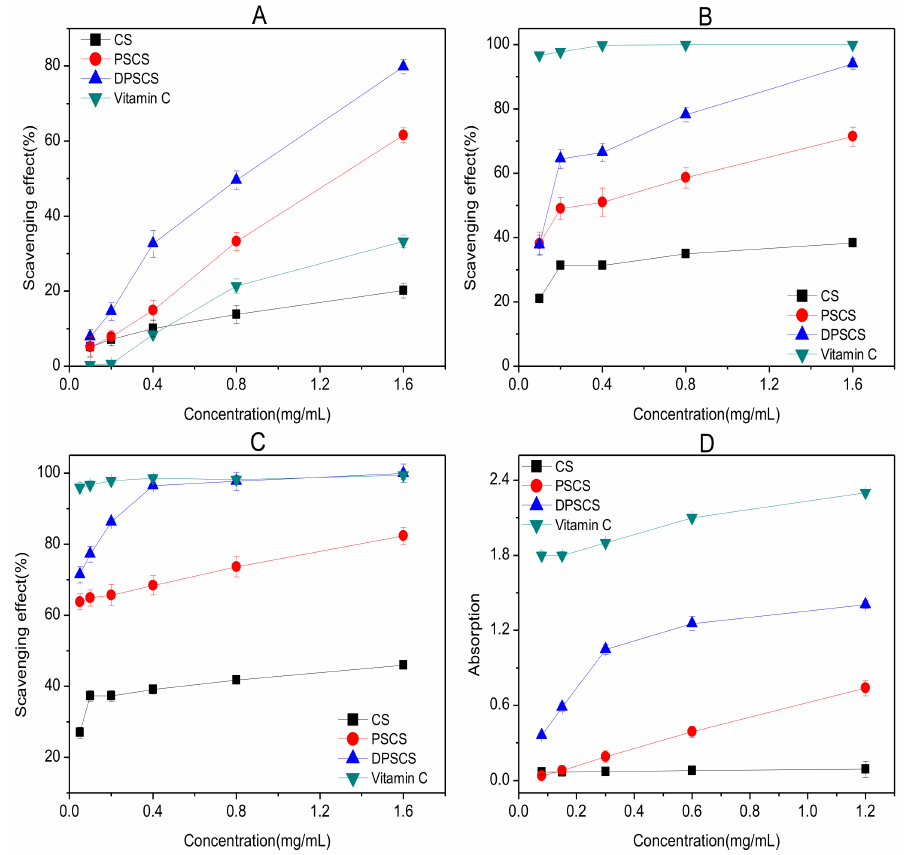
Figure 4. Antioxidant effect of samples: ( A ) Hydroxyl-radical scavenging ability; ( B ) Superoxide-radical scavenging ability; ( C ) DPPH-radical scavenging ability; ( D ) Reducing